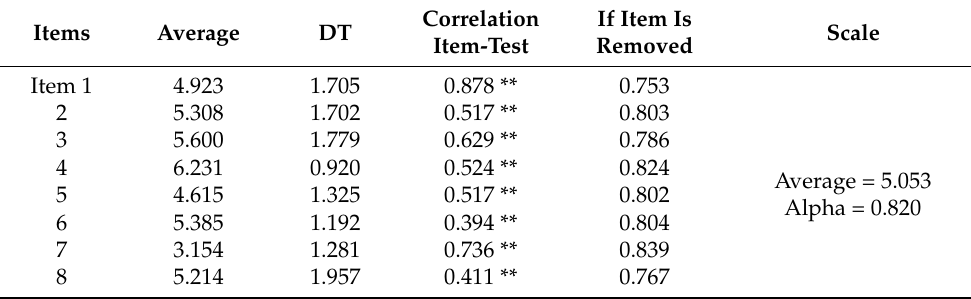
Table 6. Internal consistency of the ABA-SF factors.